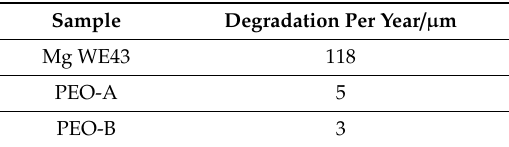
Table 1. Calculated degradation of the Mg WE43 specimens with and without PEO coating in µm/year. The results show a manifold higher degradation rate for the untreated MgWe43 samples compared to the PEO modified samples. In concordance with the hydrogen gas production measured in the bioreactor system, PEO-B shows the lowest degradation rate.